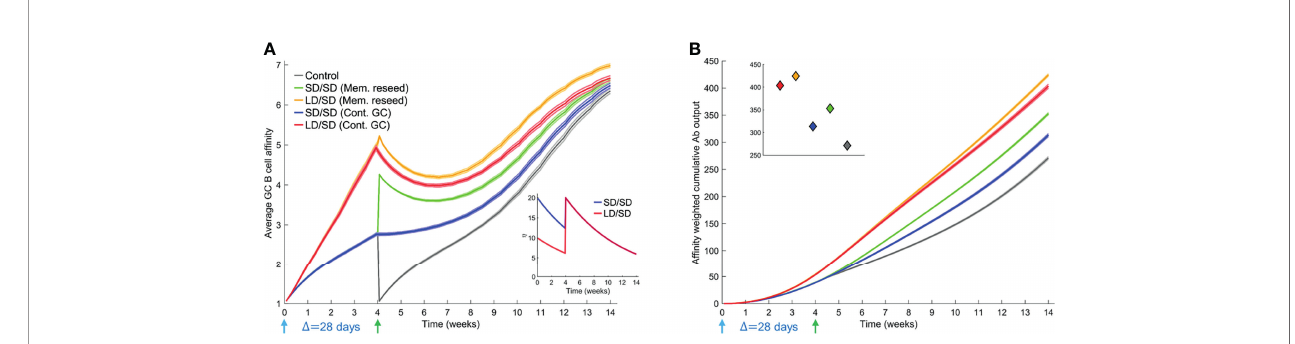
FIGURE 3 | In fl uence of different prime-boost dosages. (A) Time-evolution of the average af fi nity of GC B cells for different dosing protocols indicated. Inset: The associated antigen levels. (B) Time-evolution of the af fi nity-weighted cumulative antibody output for the cases in (A) . Inset: Corresponding values at the fi nal simulation time point. Parameters used: D =28 d; t =40 d; h 0 = 10 for LD and h 0 = 20